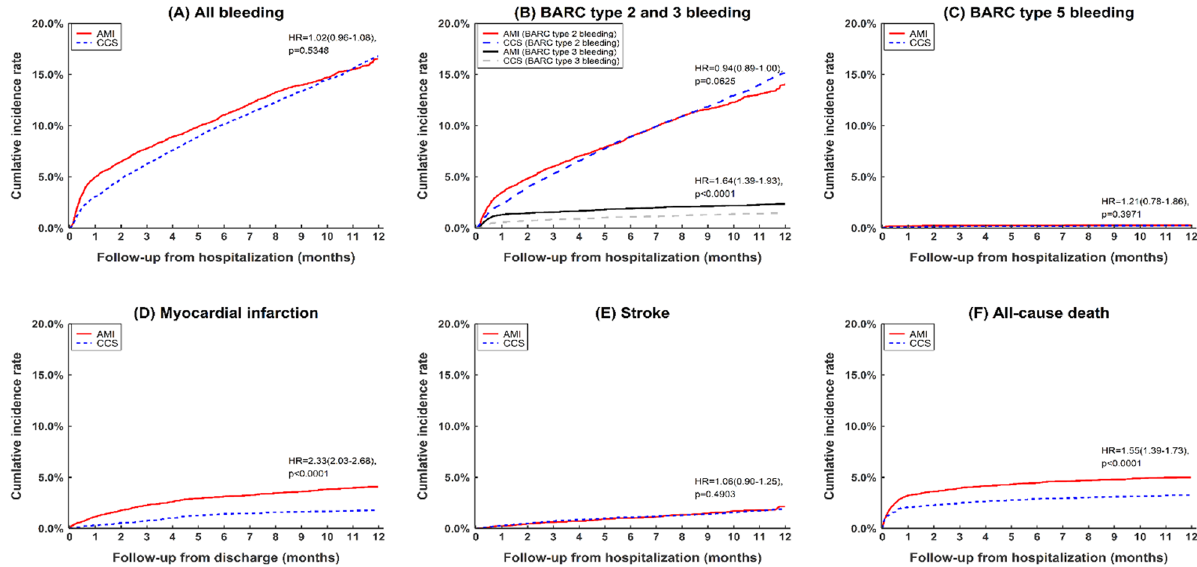
Figure 2. Cumulative incidence rates of clinical outcomes in patients with AMI versus CCS who had received DAPT after coronary stenting (after propensity score weighting). AMI, acute myocardial infarction; BARC, Bleeding Academic Research Consortium; CCS, chronic coronary